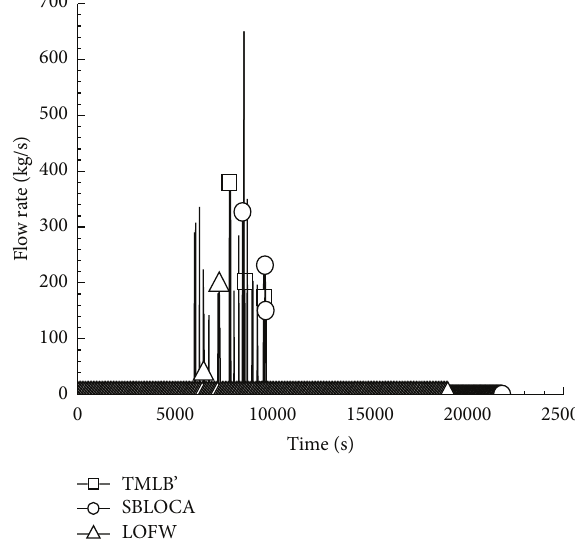
Figure 6: RCS pressure with activation of SADV.